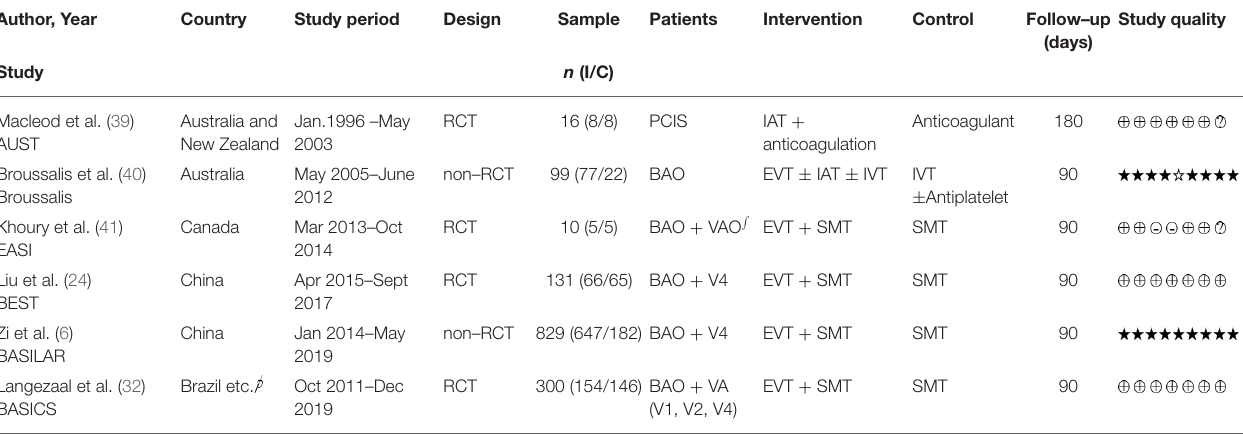
TABLE 1 | Characteristics of included six